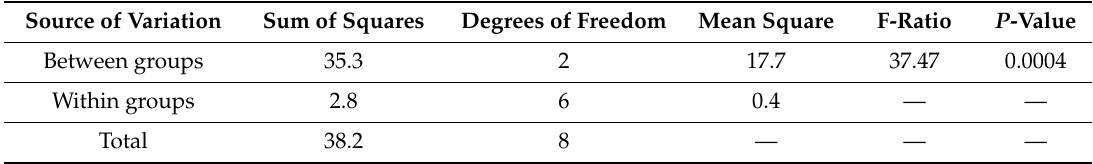
Table A1. Analysis of variance (ANOVA) corresponding to the jicama soluble matter yield as a function of extraction stirring speed.